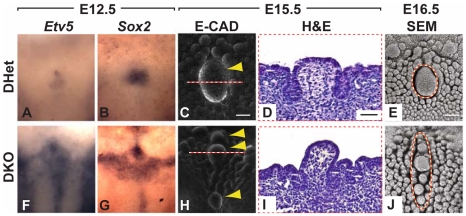
Formation of multiple CVPs in Spry1−/−;Spry2−/− (DKO) mice.(A,B,F,G) Dorsal views of the expression patterns of Etv5 and Sox2 in Spry1+/−;Spry2+/− (DHet) and DKO mice. (C,H) Multiple CVPs in the anterio-posterior direction were observed in DKO mice visualized by E-cadherin immunofluorescence staining (arrowheads). Scale bar, 50 µm. (D,I) H&E staining of coronal sections through the CVP as indicated by dashed lines in C and H. Scale bar, 25 µm. (E,J) Multiple, presumptive CVPs visualized by SEM are indicated by dashed circles. Scale bar, 50 µm.